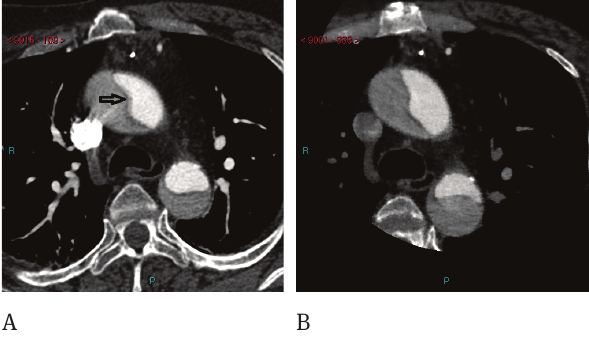
Figure 2: CT findings of type A Aortic Dissection. A) In the ungated acquisition, pulsatility artifacts are evident (arrow). B Same patient studied with cardiac gating, no pulsatility artifacts are evident.